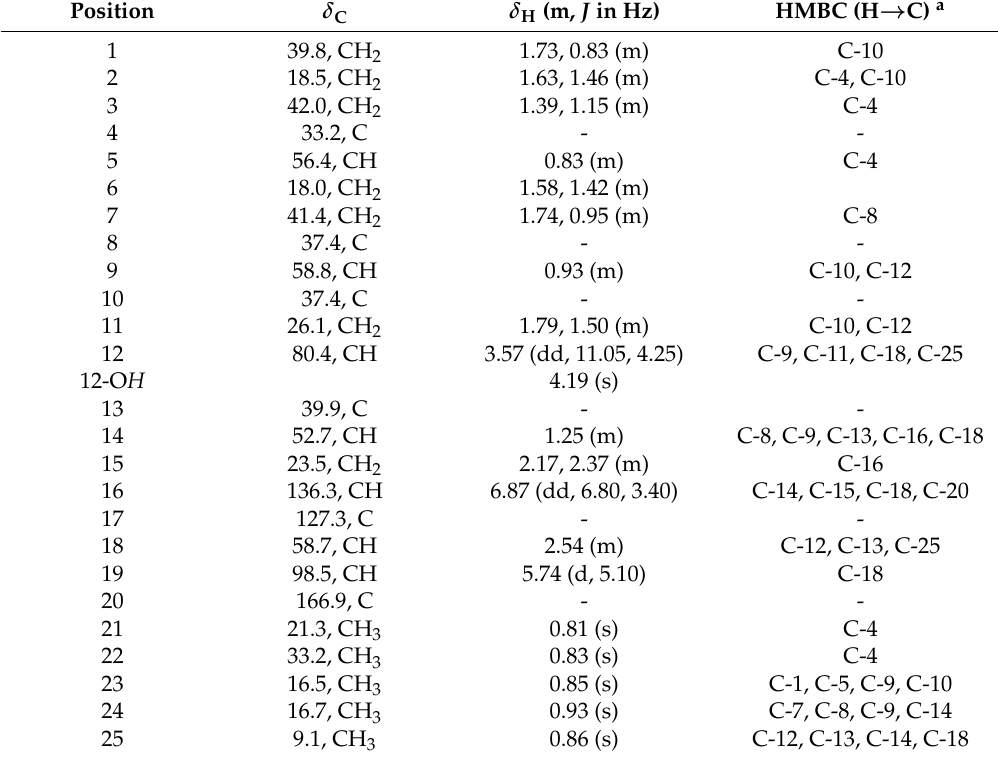
Table 1. NMR data and HMBC correlations of Compound 14 (CDCl 3 ).